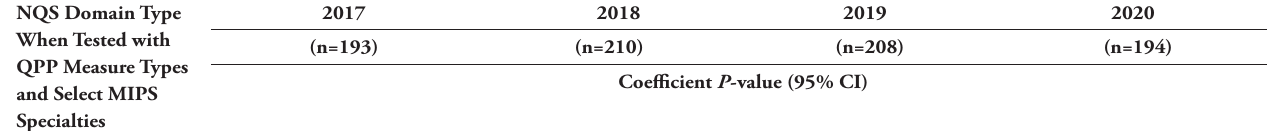
Table 6. Results of the Categorical Dependent Variable Method Binary Logit Regression Analyzed for NQS Domains When Regressed with Quality Measure Types and Clinical Specialties for Years 2017 through